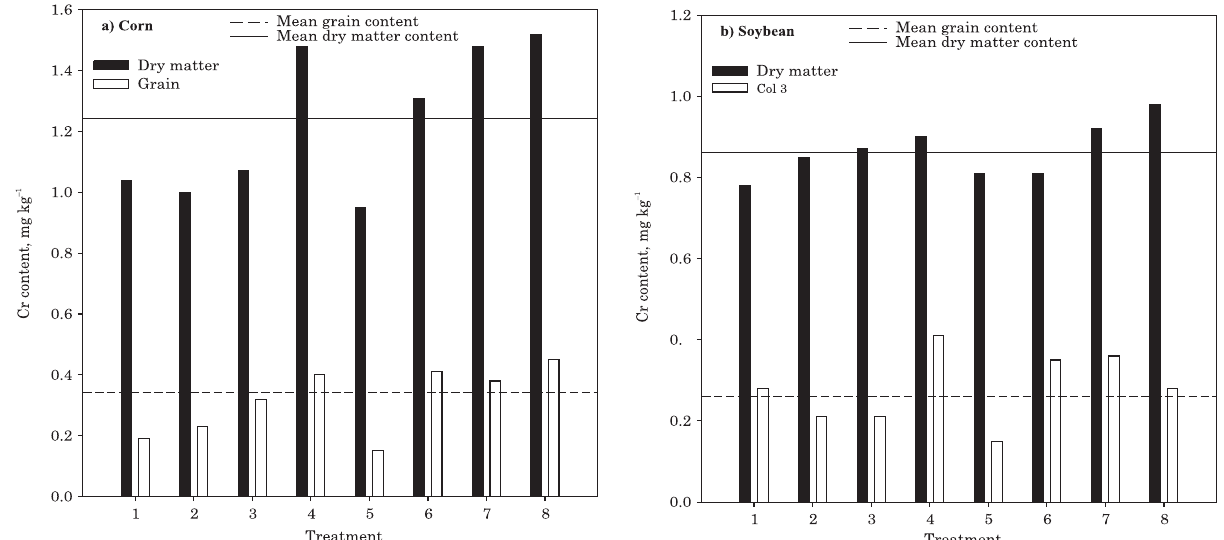
Figure 1. Plant dry matter (after flowering) and grain chromium